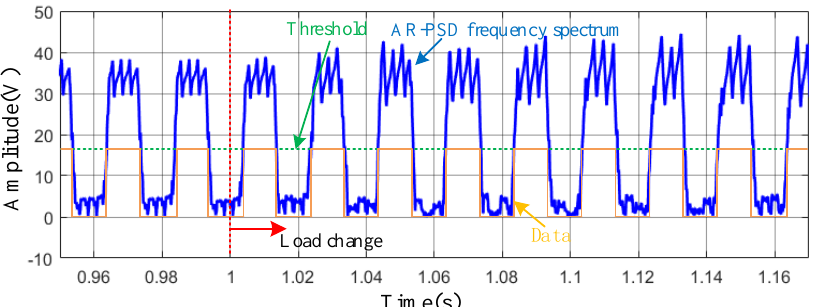
Energies 2020 , 13 , x FOR PEER REVIEW Figure 23. Frequency spectrum and demodulated data as the load is reduced from 20 Nm to 15 Nm. Figure 23. Frequency spectrum and demodulated data as the load is reduced from 20 Nm to 15 Nm. Figure 23. Frequency spectrum and demodulated data as the load is reduced from 20 Nm to 15 Nm.